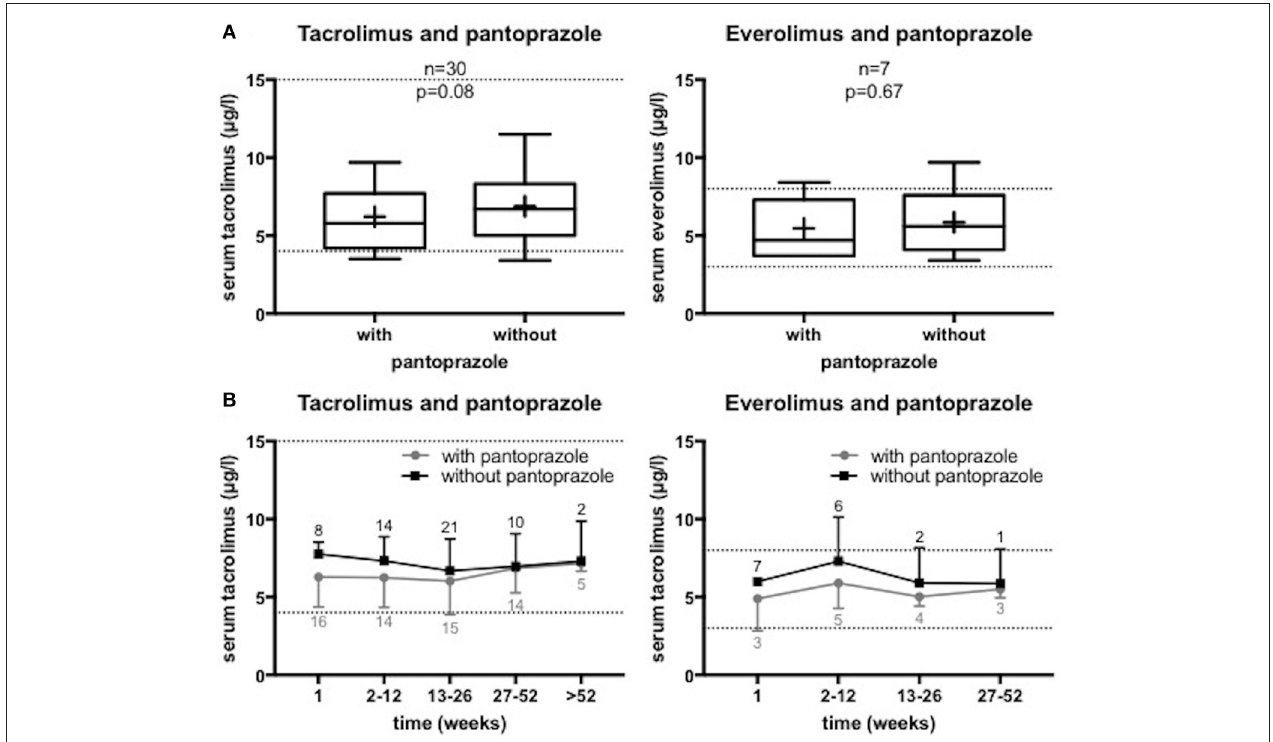
FIGURE 1 | Serum levels of the immunosuppressive drugs tacrolimus and everolimus in the presence or absence of pantoprazole in liver transplant recipients. We analyzed the serum trough levels of the immunosuppressive drugs around start or stop of a continuous oral pantoprazole therapy with 40mg once daily. All included patients got constant co-medication and constant immunosuppressive drug dosage. The dashed lines mark the therapeutic range of the serum trough levels. (A) Analysis of the serum levels measured before and after change of a pantoprazole therapy. The mean observation period was 6.5 ± 8.8 weeks in the tacrolimus group ( n = 30) and 7.8 ± 7.9 weeks in the everolimus group ( n = 7), respectively. Data are shown as boxplots in Tukey style. + = mean value. (B) Analysis of the serum levels depending on admission or omission of pantoprazole over a period of at least 52 weeks before and after change of pantoprazole co-administration. All routine measurements of the serum trough levels with and without PPI co-administration during the observation period are demonstrated. Data are shown as means with standard deviation of the number of patients indicated.